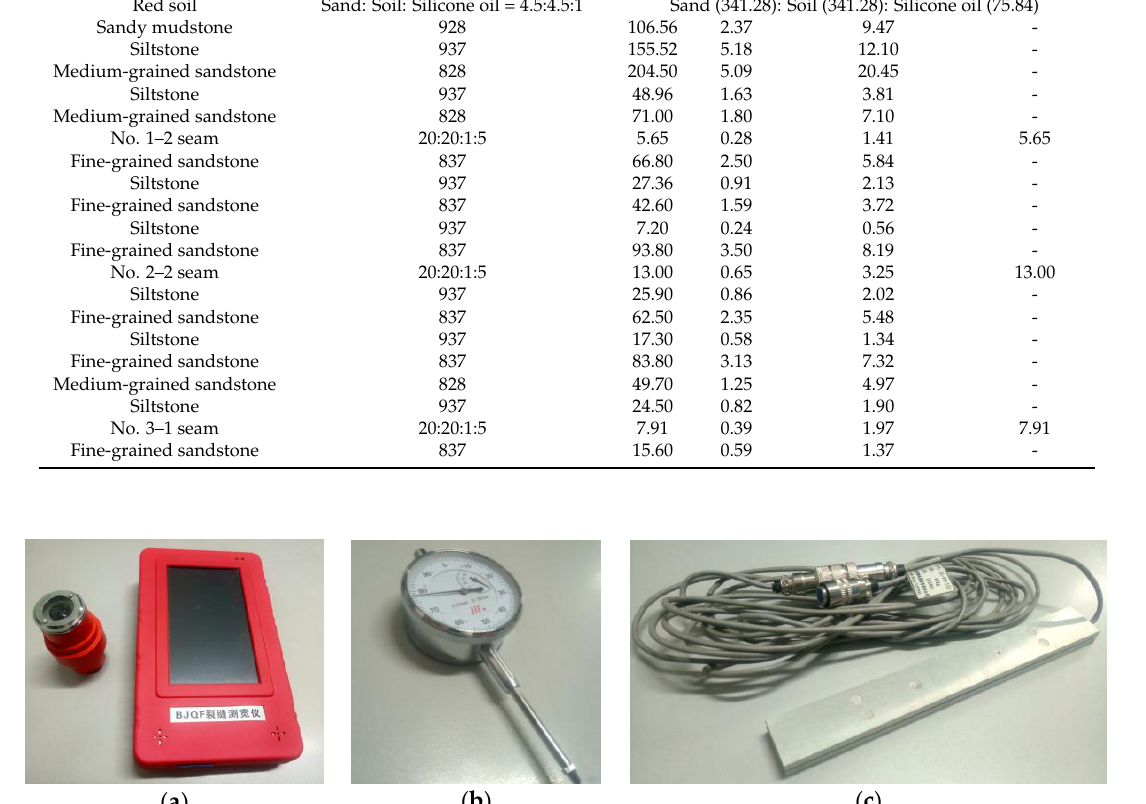
Figure 5. Experimental monitoring system: ( a ) Fracture width gauge; ( b ) Dial indicator; ( c ) Force test sensor.